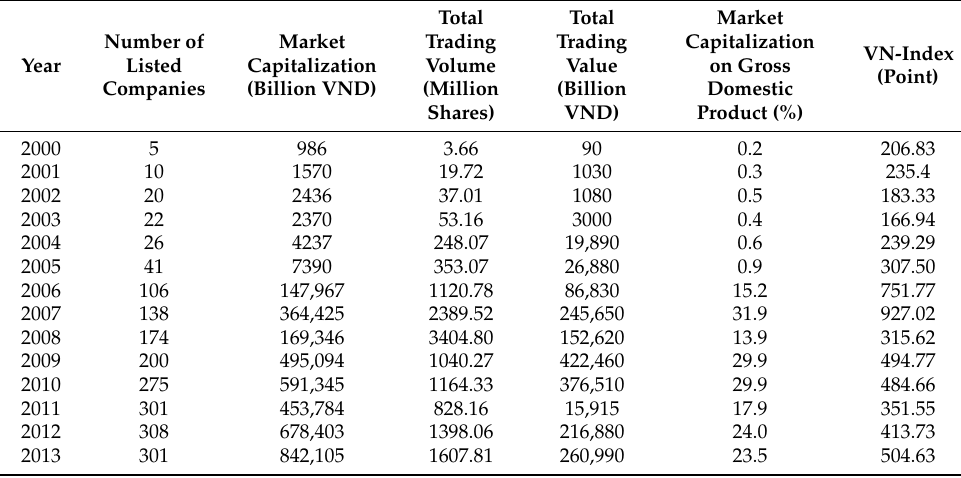
Table 1. Some indicators for the HOSE during the period of